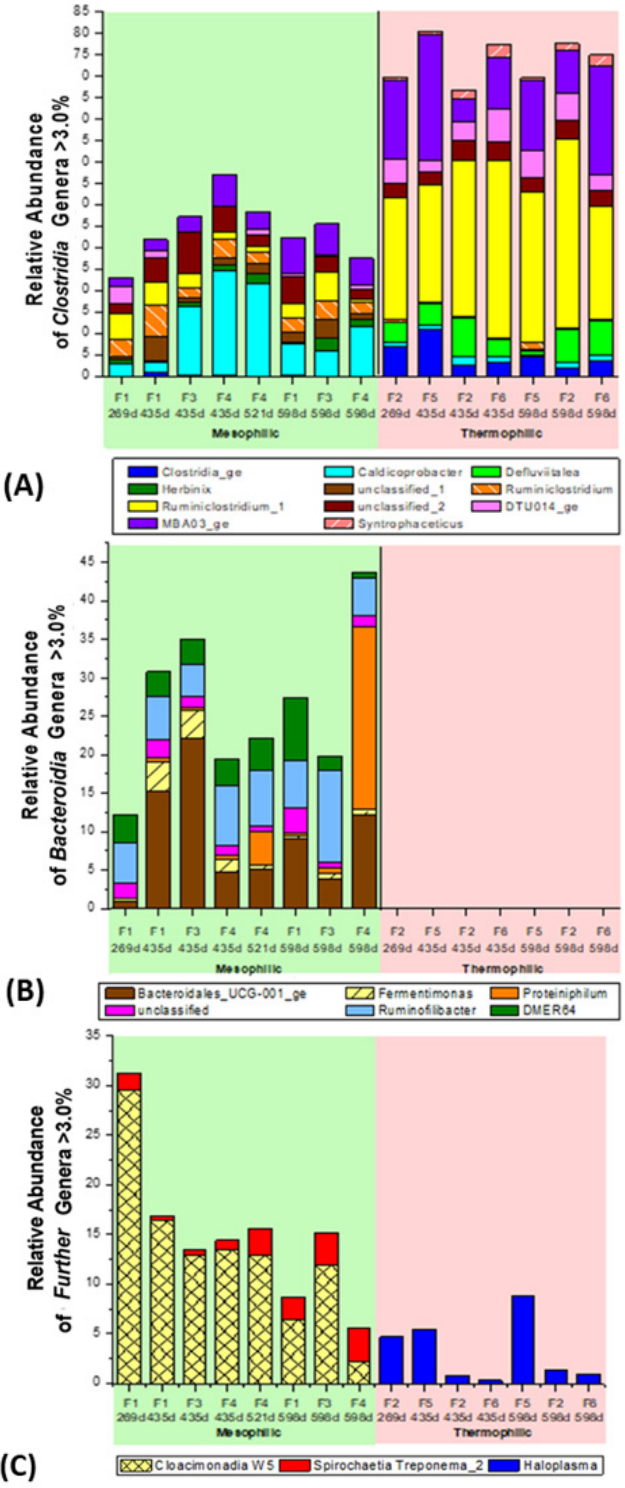
Figure 7. Relative abundance of the dominant microbial genera, with an abundance of >1.0% or 3% (major players), which were recorded by NGS analysis in the different mesophilic and thermophilic wheat straw fermenters F1–F6 (Figure 1B), with ‘synthetic manure’ as defined medium. ( A ) Clostridia Genera > 3%, ( B ) Bacteroidia Genera > 3%, ( C ) Further Genera > 3%.